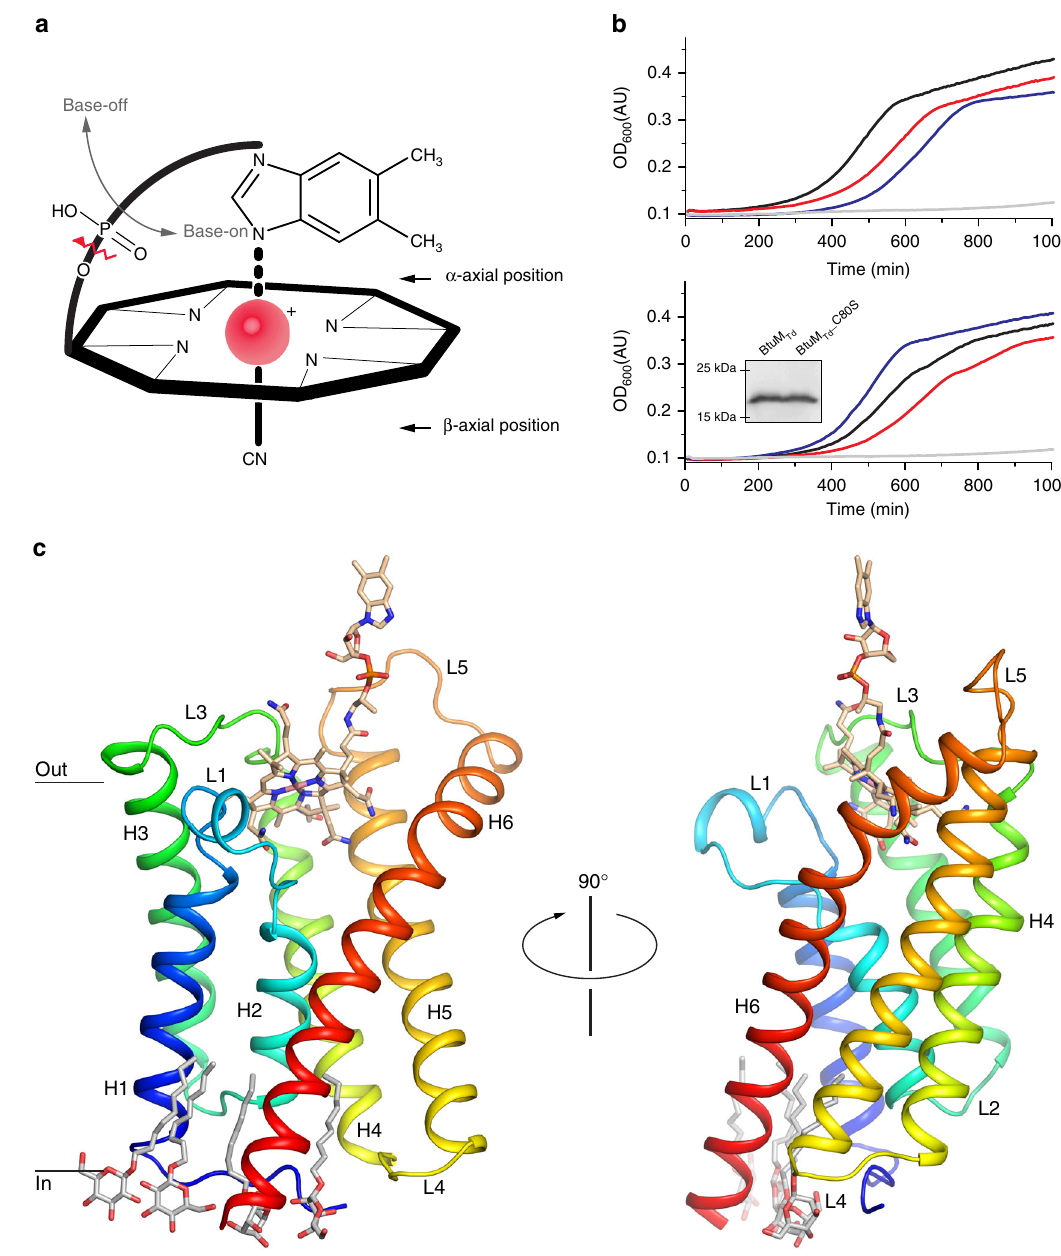
Fig. 1 Function and structure of BtuM Td . a Schematic representation of cobalamin (Cbl) showing the corrinoid ring with the central cobalt ion (red). The ligand at the β -axial position is in this case a cyano-group, but differs in various Cbl variants (Supplementary Figure 1a, b). The ligand at the α -axial position (base-on conformation) is the 5,6-dimethylbenzimidazole base, which is covalently linked to the corrinoid ring. When this coordination is lost, Cbl is termed base-off. Cbi lacks the 5,6-dimethylbenzimidazole base (indicated by the zigzagged red line). b Growth assays with E. coli Δ FEC was conducted in the presence of 50 μ g ml − 1 L -methionine or 1 nM Cbl. Additional experiments in the presence of different Cbl concentration are shown in Supplementary Figure 2f and g. All growth curves are averages of nine experiments (three biological triplicates, each with three technical replicates). Top panel: cells containing the empty expression vector (pBAD24) in the presence of methionine (blue line) or Cbl (grey line) and cells expressing the BtuCDF system (black and red lines, respectively). Bottom panel: cells expressing BtuM Td (black and red lines) or mutant BtuM Td _C80S (blue and grey) in the presence of methionine and Cbl, respectively. The inset displays a western blot showing that the mutant is expressed to wild-type levels (the full-length western blot can be found in Supplementary Figure 2h). c The structure of BtuM Td in cartoon representation, coloured from blue (N terminus) to red (C terminus) and viewed from the membrane plane. α -helices (H1-6) and connecting loops (L1-5) are indicated. Cbl is shown in stick representation with carbon atoms coloured wheat, the oxygen and nitrogen atoms in red and blue, respectively, the cobalt ion in pink. Four n -nonyl- β - D -glucopyranoside detergent molecules are also shown in stick representation (carbons in light β -axial position is altered, allowing among others a variety of membrane transporter BtuB 20 , and human Cbl-carriers intrinsic methyl-group transfer reactions 1 . Therefore, the base-off binding factor 21 , haptocorrin 22 and transcobalamin 23 . Enzymes that bind Cbl with the base-off conformation usually use a histidine residue mode by BtuM Td could indicate that the protein may exhibit enzymatic activity. as the α -axial ligand. In this way, the reactivity of the cobalt at the